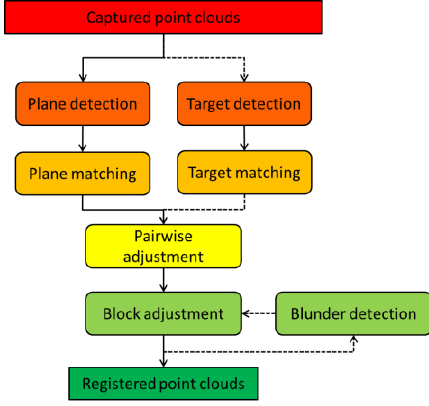
Figure 1. Flow chart of